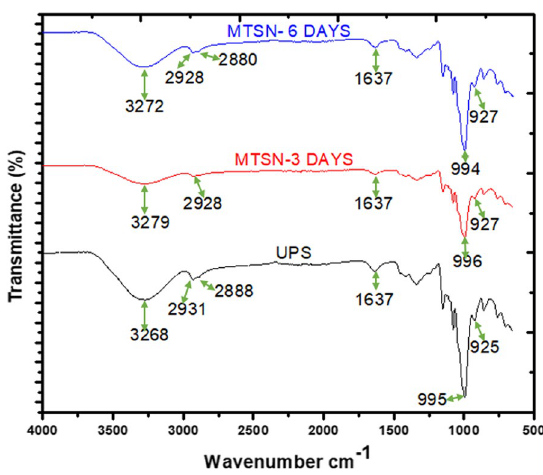
Fig. 6 The overlay of FTIR spectra of UPS, MTSN-3 days, and MTSN-6 days. The comparison of the Fourier transform infrared spectrum of